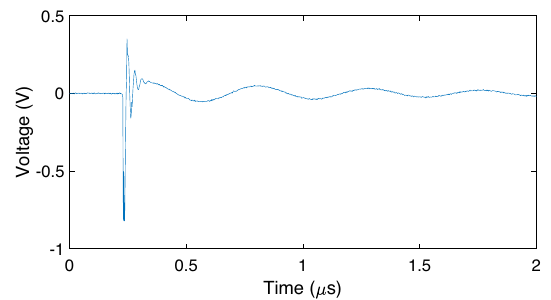
FIG. 2. Electric field adjacent to an electrode surface, in the vicinity of its ridge, for (a) crossed and (b) parallel electrodes. The applied voltage is 5 kV.